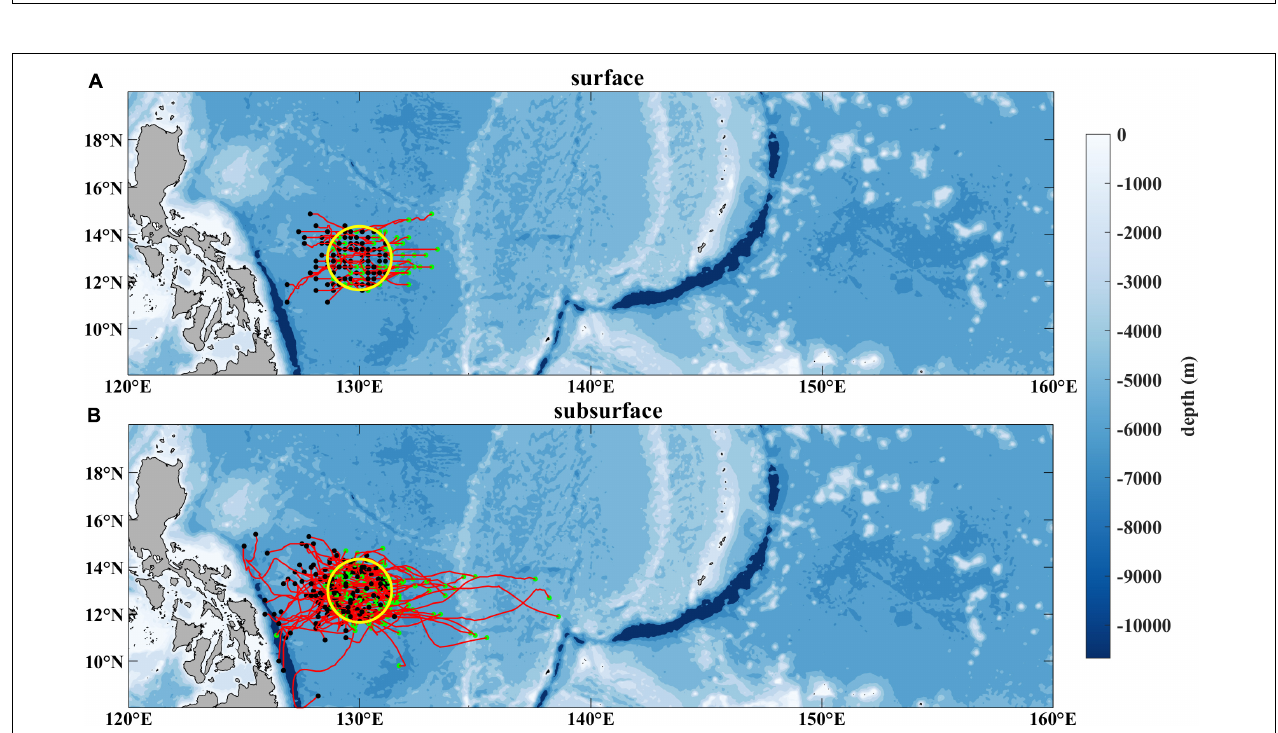
Frontiers in Marine Science |